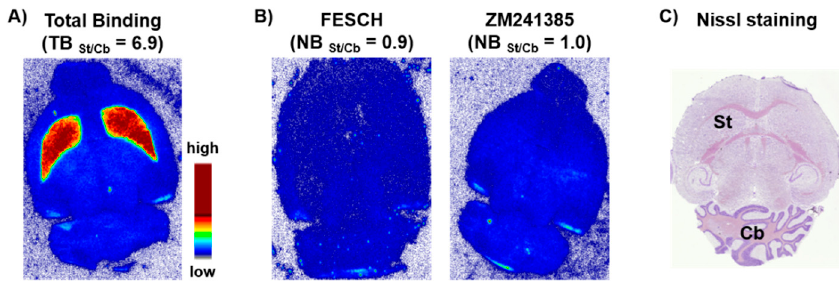
Figure 3. Representative autoradiographic images of transversal CD-1 mouse brain slices. ( A ) In vitro distribution of activity after incubation with 0.2 MBq/mL of [ 18 F] FESCH (TB = total binding). ( B ) Non-specific binding (NB) of [ 18 F] FESCH determined in the presence of 1 µM of FESCH or ZM241385 , respectively, as blocking agents. ( C ) Nissl staining, St = Striatum, Cb = Cerebellum.